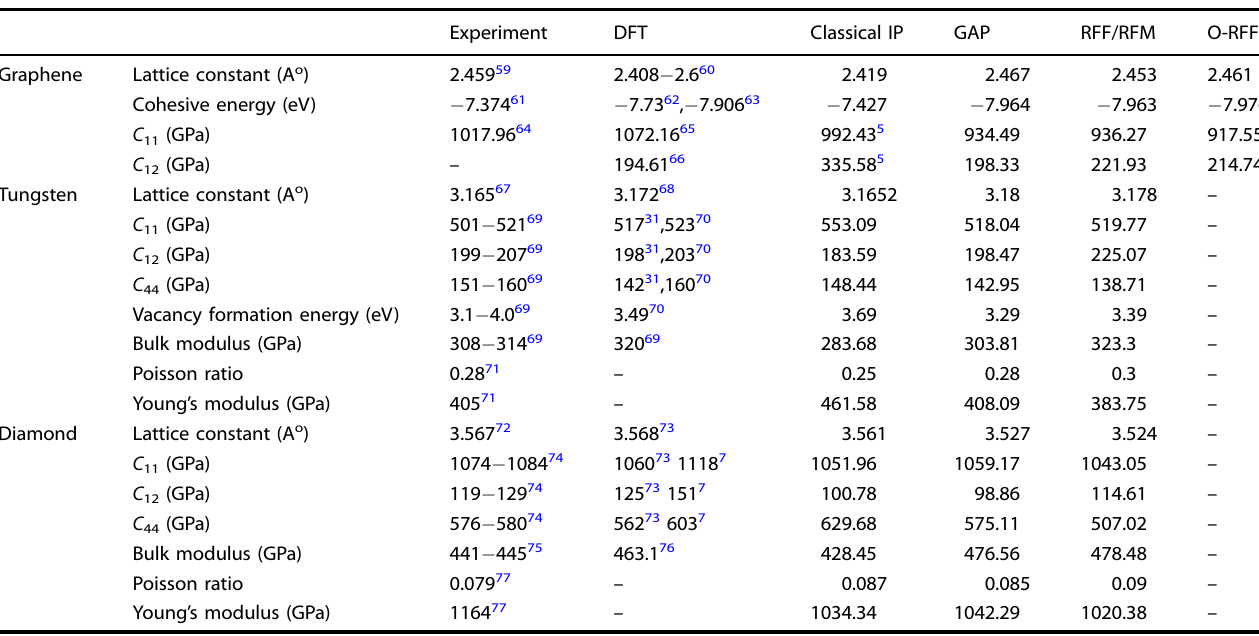
Table 3. Table of physical properties as computed using various methods.